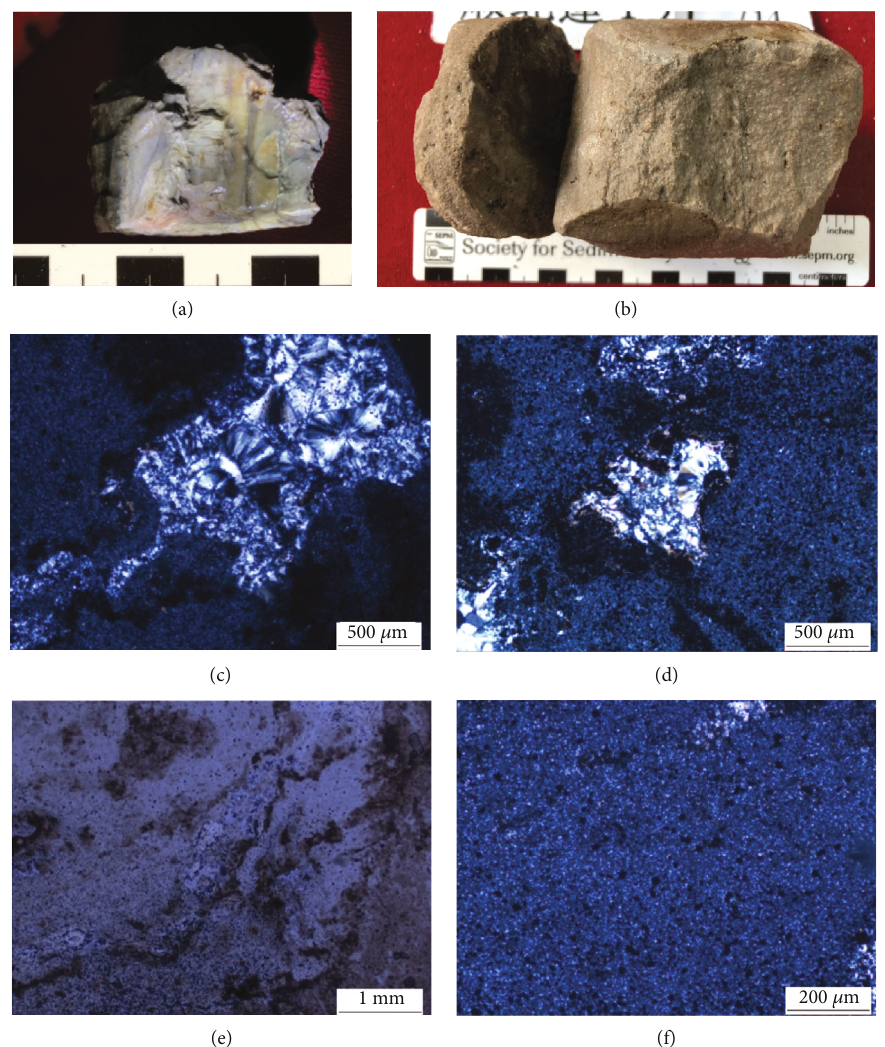
Figure 2: The lower unit characteristics of Well SHBP1. Microscopic/petrographic characteristics of samples in the lower core: (a) Light gray siliceous rock. Silici fi cation develops along fractures, layered siliceous bands, and pyrite, 8455.71-8455.73m; (b) Light gray siliceous rock. Silica is mainly cryptocrystalline, quartz crystal growth, and residual fi lling along the fracture wall can be seen on the fracture surface, 8455.73-8455.77m; (c) Qtz is present as the subhedral quartz crystal, which developed a few pores. Quartz fi lls the fractures, chalcedony is fi lled in the fractured-cavity, as observed in microscopic photo of XPL, 8455.74m; (d) Silici fi ed rock with crystalloblastic texture is composed of microcrystalline quartz and granular quartz, with large intercrystallite pores and reprecipitated calcite cement, 8455.73m, XPL; (e) Siliceous rocks. It is dominated by microcrystalline quartzite, which consists of microcrystalline quartz and granular quartz with crystalloblastic texture, 8455.72m, PPL; (f) Siliceous rocks. Partially magni fi ed slice of E, microcrystalline quartz, 8455.72 m,